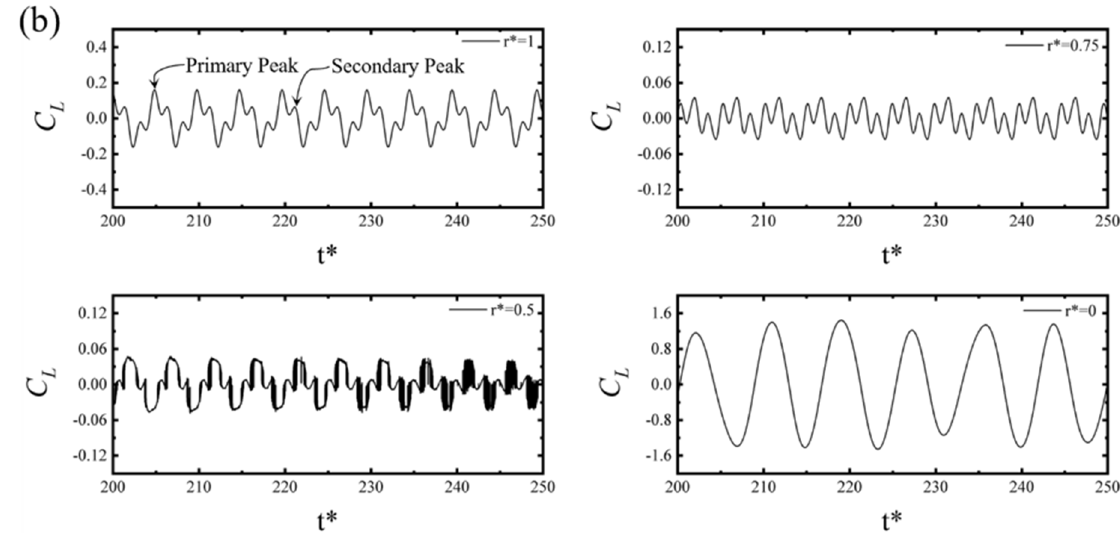
Figure 9. ( a ) Frequency response of free oscillating cylinders with varying corner radii and different Reynolds numbers from 100 to 200. ( b ) Time histories of Re = 200 with varying r *.